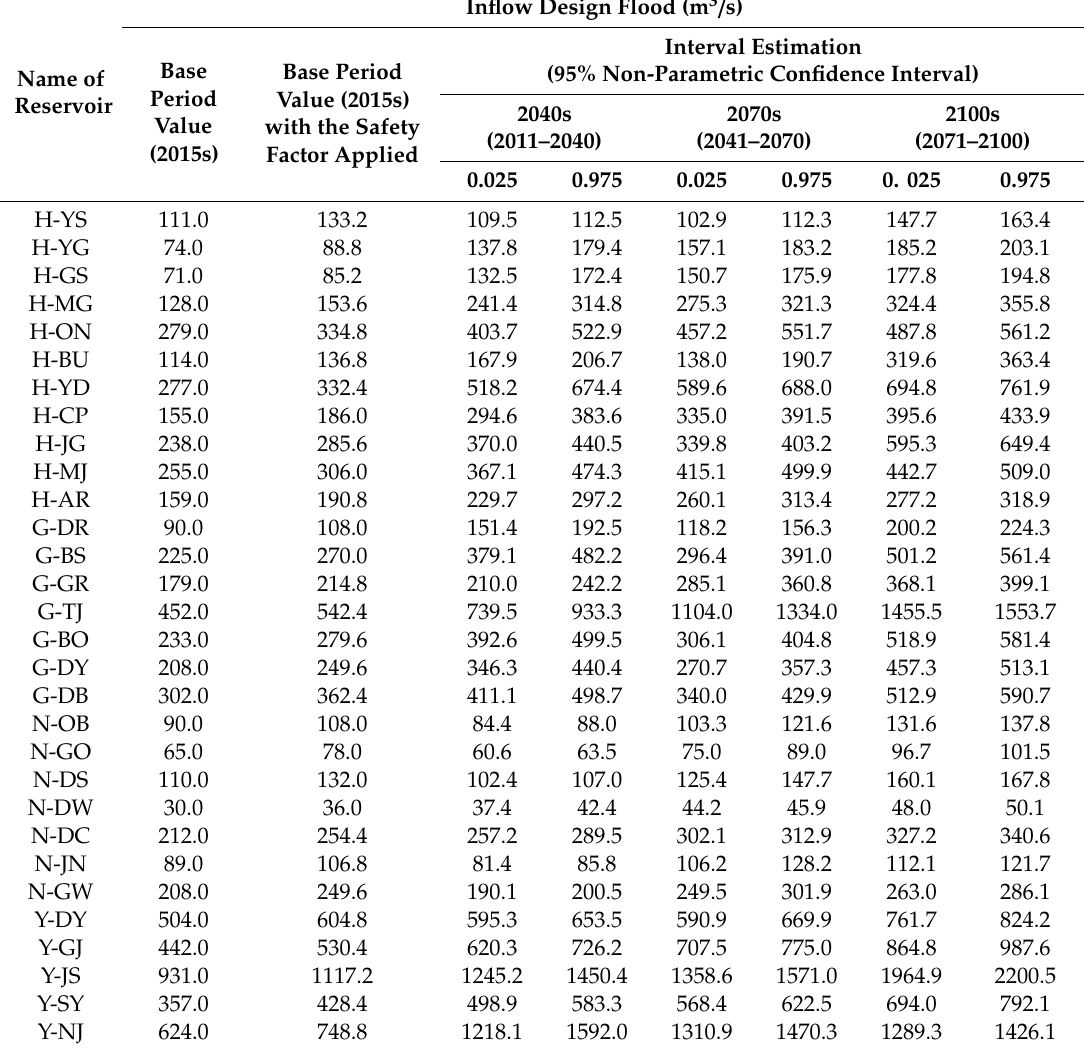
Table 4. 95% non-parametric confidence interval of the inflow design flood for a 24-h duration and a 200-y return period for three future periods under the RCP4.5 scenario for 30 agricultural